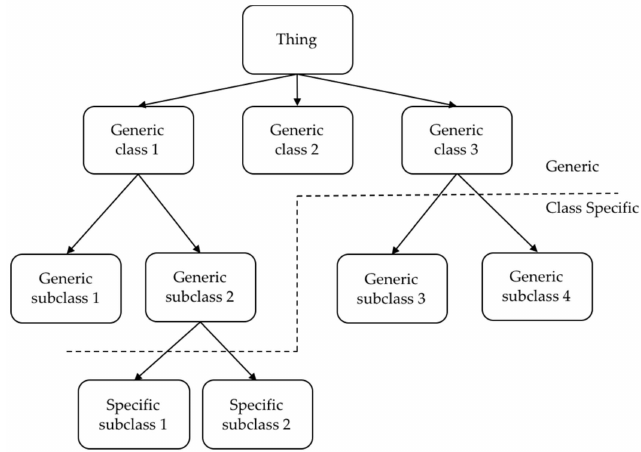
Figure 3. The border between generic and domain-specific class in an ontology [103].